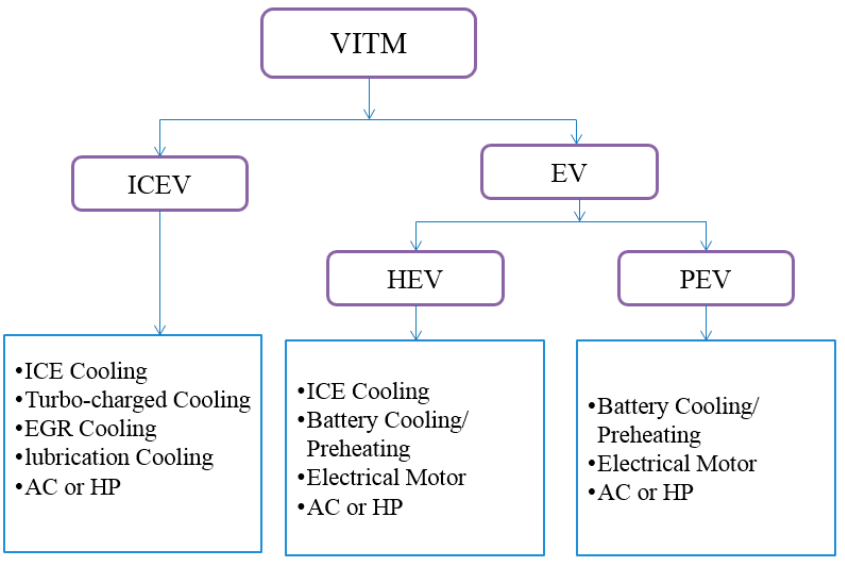
Figure 1. The classification of vehicle integrated thermal management (VITM) systems.